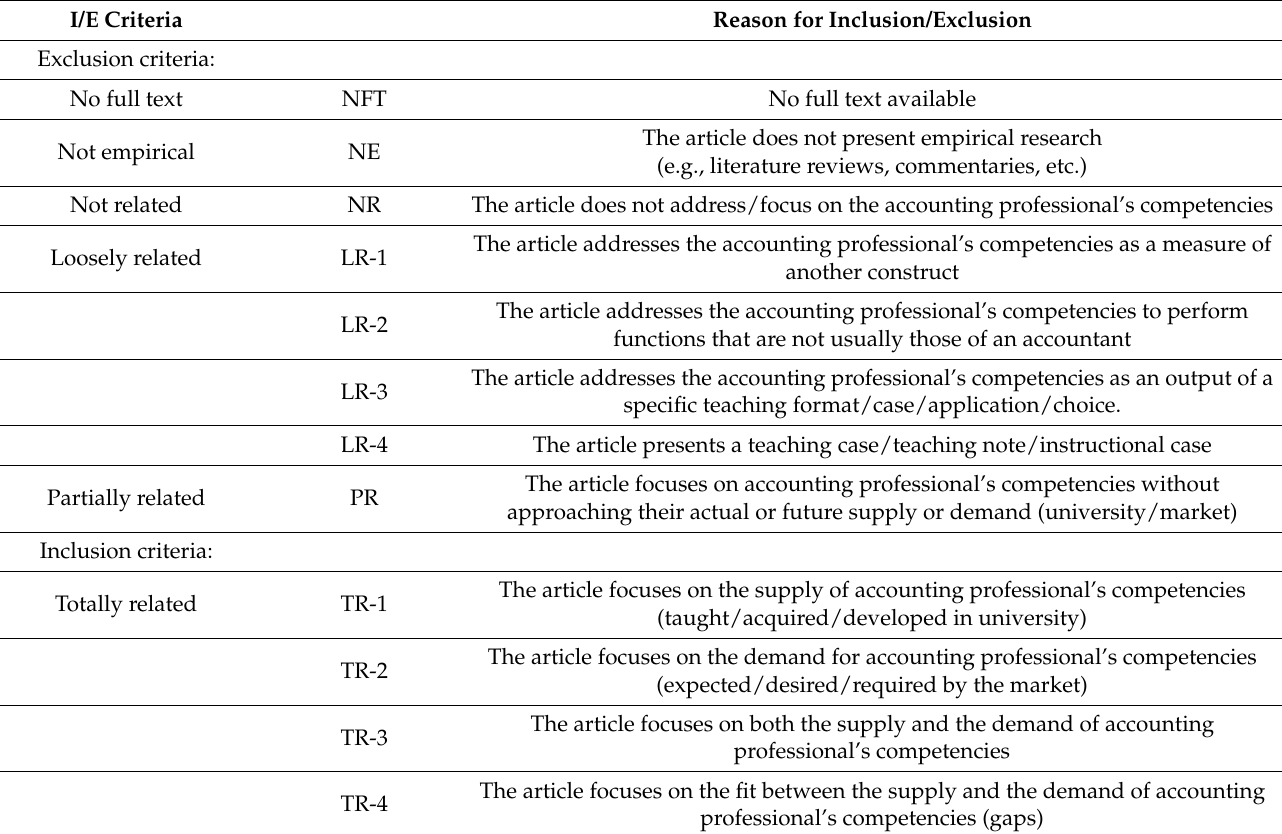
Table 2. Inclusion and exclusion